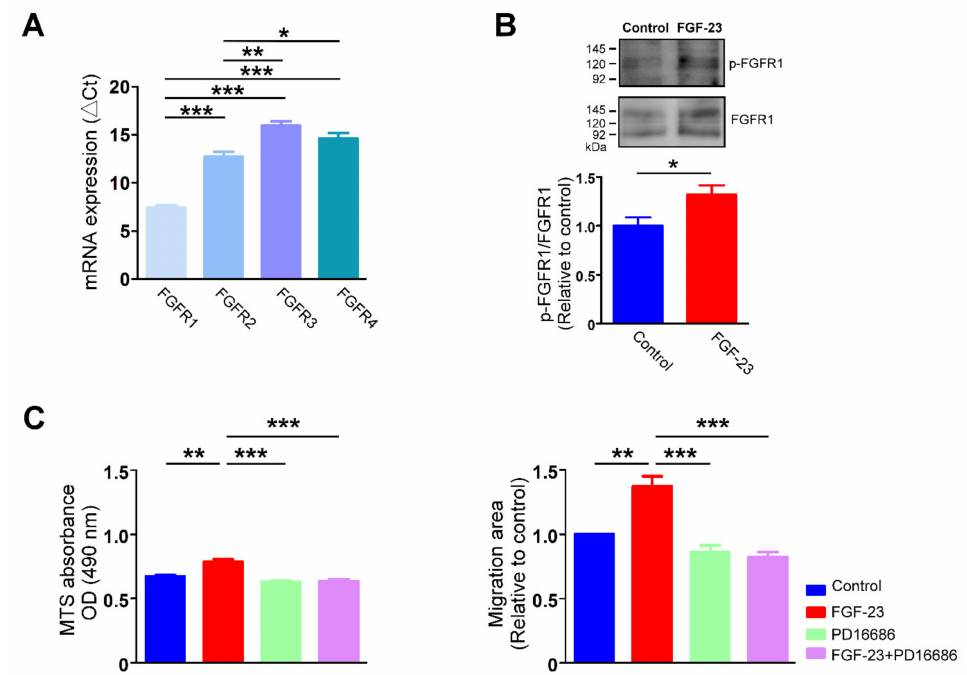
Figure 3. Fibroblast growth factor (FGF)-23 stimulates cardiac fibroblast proliferation and migration through the activation of FGF receptor 1. ( A ) FGF receptor 1–4 mRNA expressions in human atrial fibroblasts ( n = 5) using RT-qPCR. Relative mRNA abundance of FGF receptor 1–4 was estimated from the threshold cycle (Ct) value and normalized to the respective Ct value of glyceraldehyde 3- phosphate dehydrogenase ( ∆ Ct). ( B ) FGF receptor 1 phosphorylation analysis using immunoblotting from cells stimulated with FGF-23 (25 ng/mL) for 15 min ( n = 5). ( C ) Average data of a MTS assay to study cell proliferation (left panel) and a wound-healing assay to evaluate cell migration (right panel) in control and FGF-23 (25 ng/mL)-treated cardiac fibroblasts without and with PD166866 (a